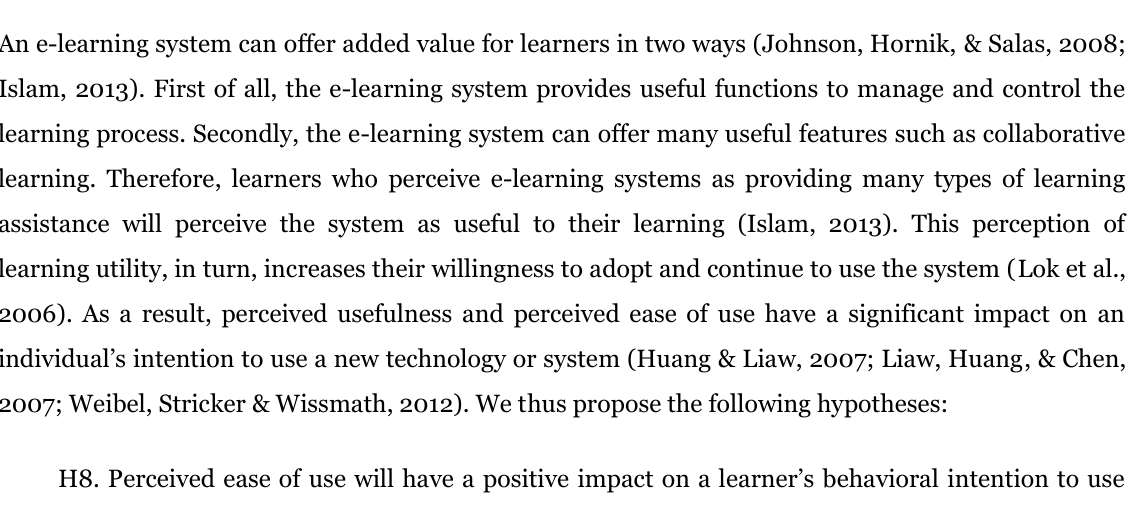
Figure 3. For the E-commerce learning system, there are six learning topics: logistics, cash flow, online marketing, e-commerce types, information security, and mobile commerce. Learners